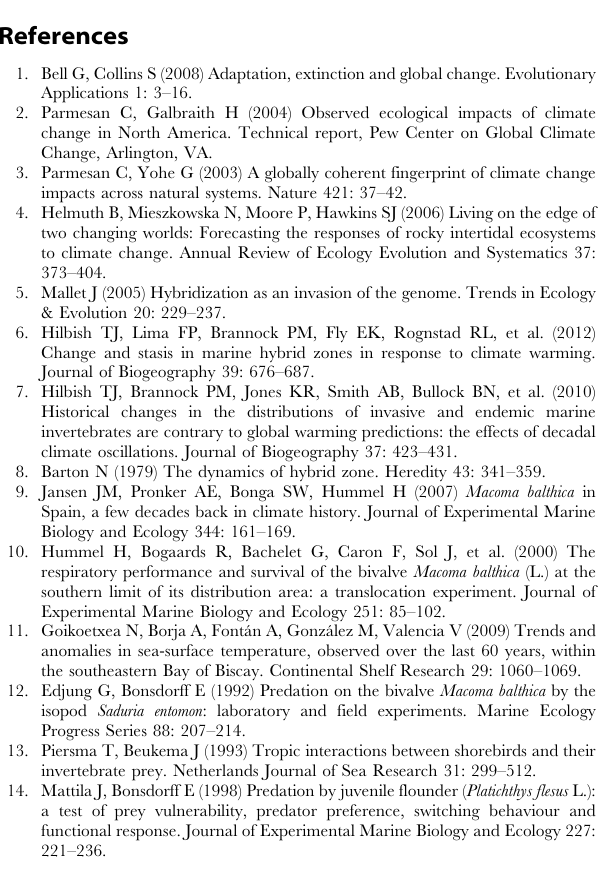
Table S1 Description of nuclear contigs with